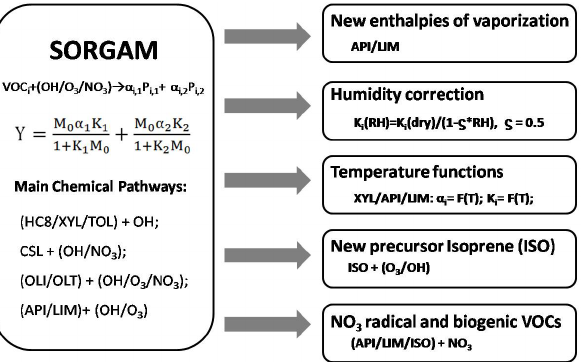
Fig. 1. A schematic view of the updates we applied to the original SORGAM